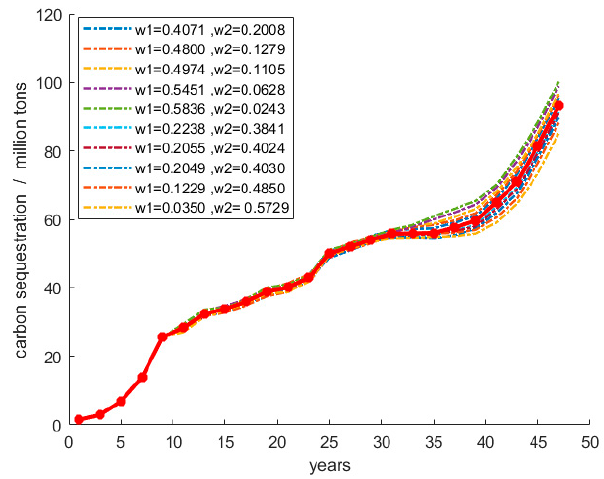
Figure 7. Sensitivity analysis with weights sampled from a Gaussian distribution. The sensitivity analysis of the three important parameters α i , β i , and δ i in the EEE model is shown in Figure 8.